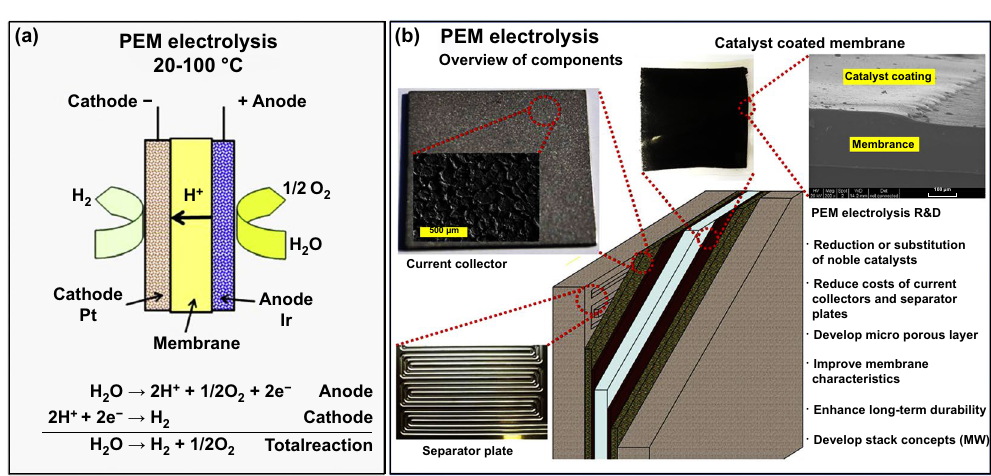
Fig. 6 a Schematic diagram of the working principle and b composition of a PEM water electrolysis. Reproduced with permission from Ref. [65]. Copyright 2013 Elsevier